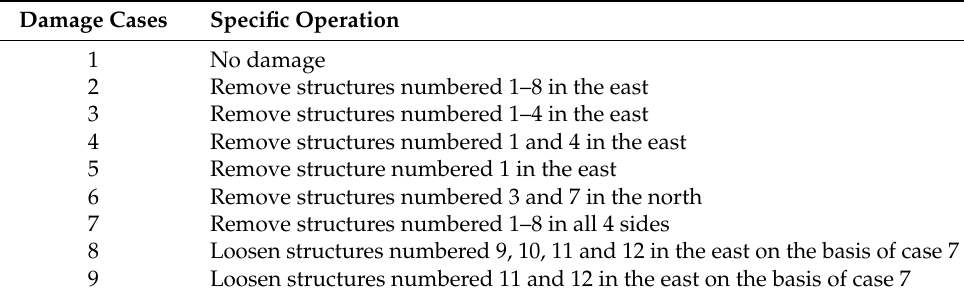
Table 1. Damage cases of frame